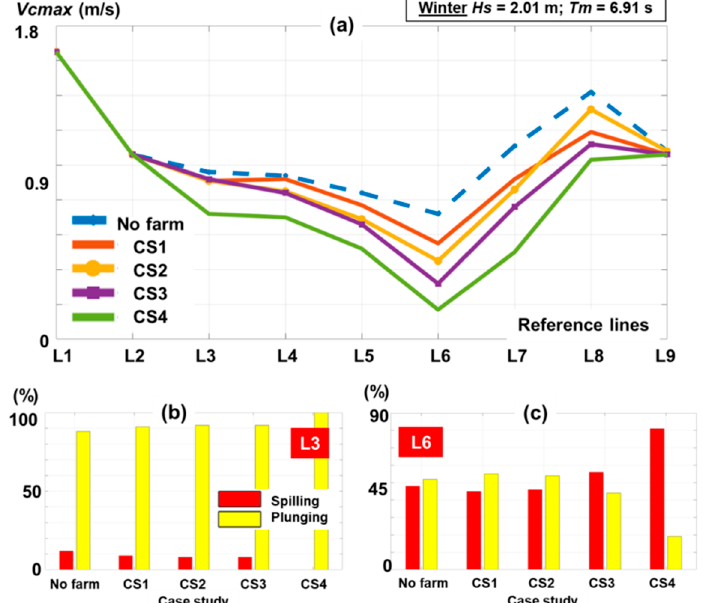
Figure 13. Evaluation of the nearshore processes considering an energetic winter event (winter A), where: ( a ) maximum nearshore current velocities (in m / s) along the reference lines; ( b ) and ( c ) balance between the wave spilling and plunging along the lines L3 and L6, in percentage.